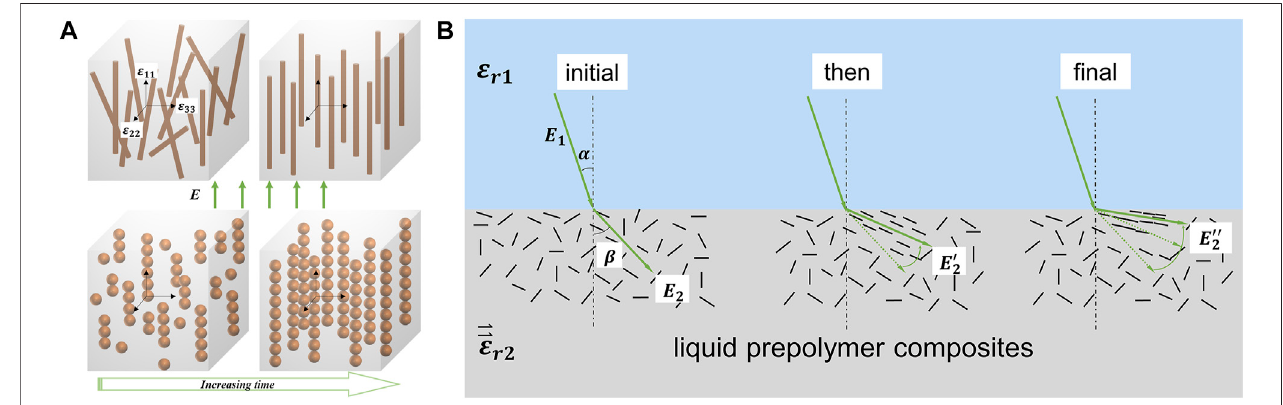
FIGURE3| Changesinmagnitudeanddirectionofthedielectrictensor: (A) self-assemblyprocessof fi llersinanelectric fi eld; (B) rotationoforientationaxisof fi llers near the interface.